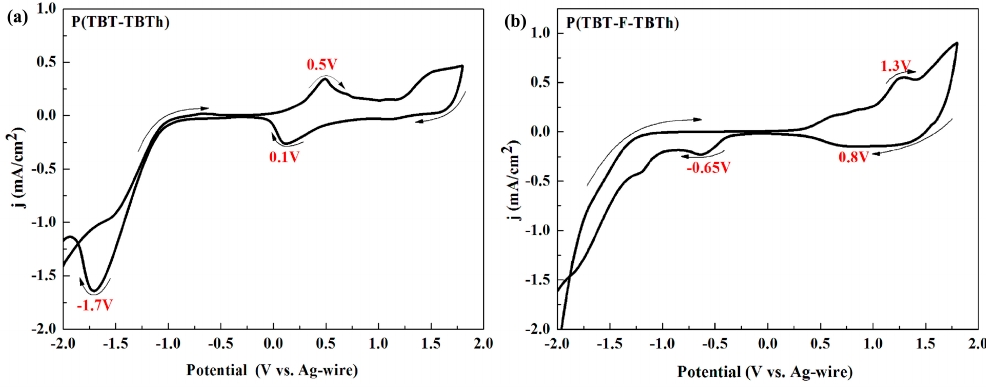
Figure 2. Cyclic voltammetry (CV) curves of the polymer films: (a) P(TBT-TBTh); (b) P(TBT-F-TBTh).